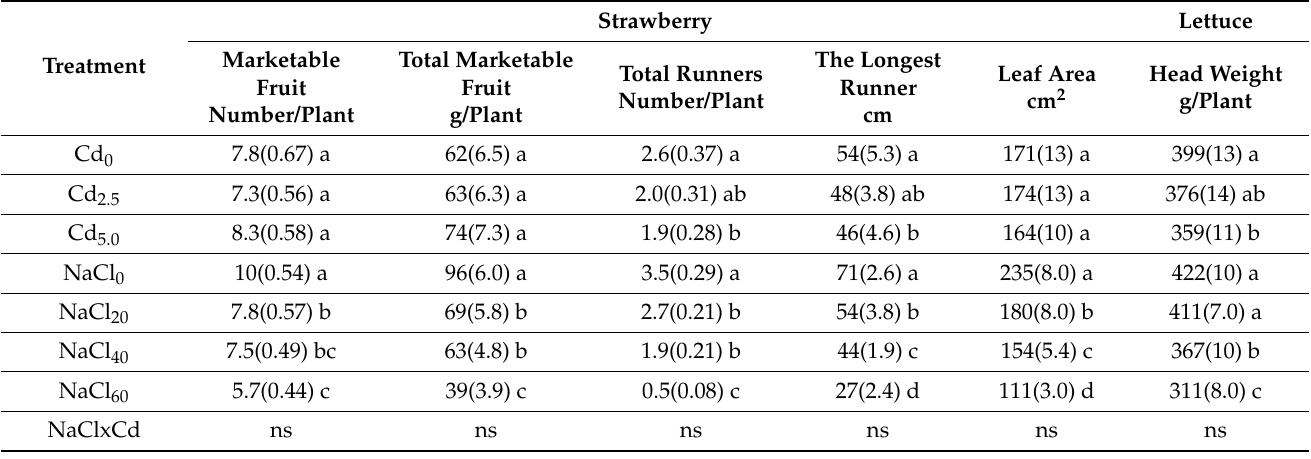
Table 1. Impact of applied treatments on vegetative growth and yield parameters of test plant species 70 days (strawberry) and 30 days after salinity treatment commenced (lettuce). Means (standard errors in parenthesis; n = 4) with the same letter in a column for a given main effect are not significantly different, according to the Tukey’s HSD test.